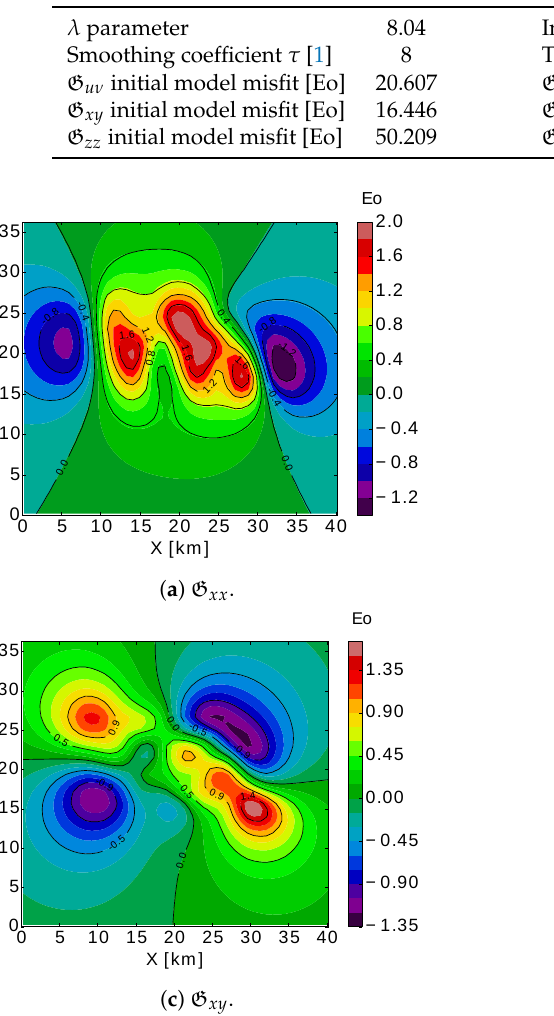
Table 10. Configuration of the gradiometric inversion parameters for the salt body.